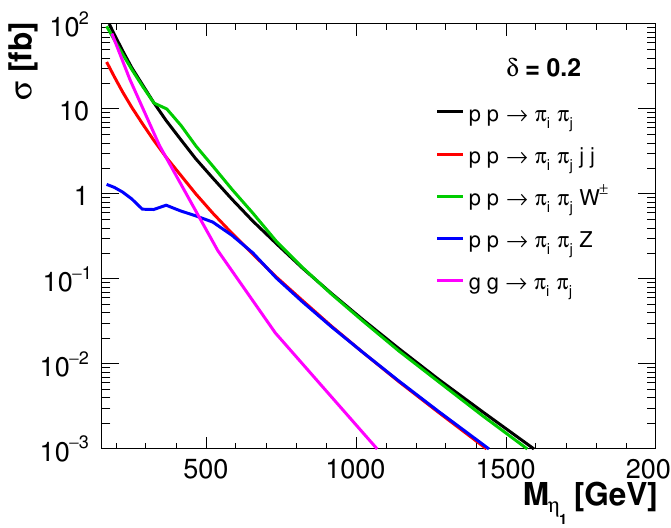
Figure 3 . Inclusive production cross sections of DM-odd pNGBs (cid:25) i at the LHC with centre of mass energy of 14 TeV, as a function of the mass for (cid:12)ve di(cid:11)erent channels. We applied a general cut on the transverse momentum of jets of p jet > 20 GeV. The dominant production channels are T due to Drell-Yan and associated production with a W